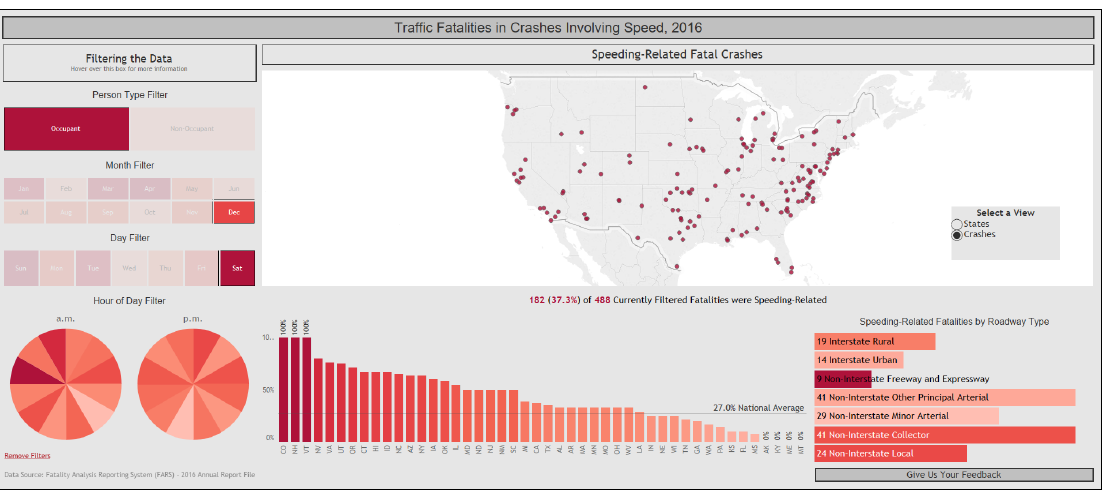
Figure 5. Symbol map showing the location of vehicle occupants killed in speed-related crashes in the US in December, 2016. The dashboard is available at